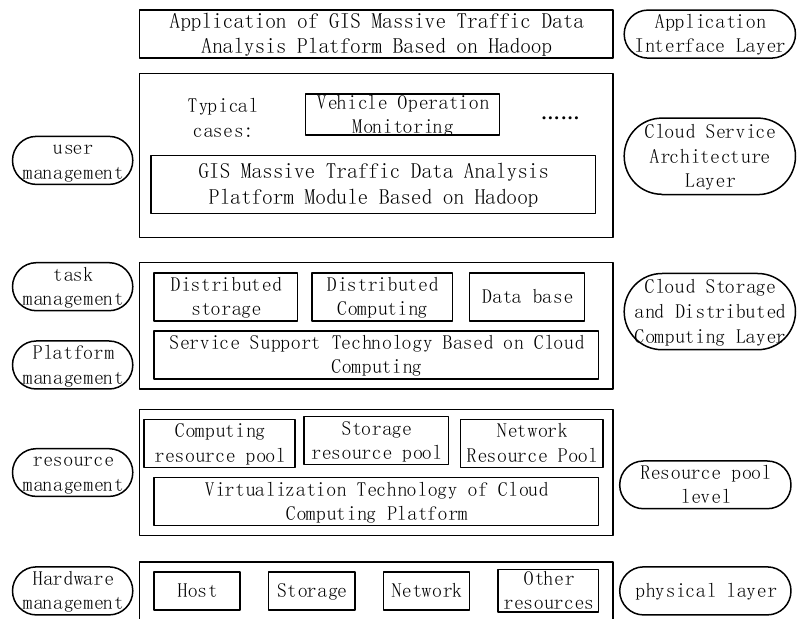
Figure 2. Hadoop-based GIS Massive Traffic Data Analysis Platform